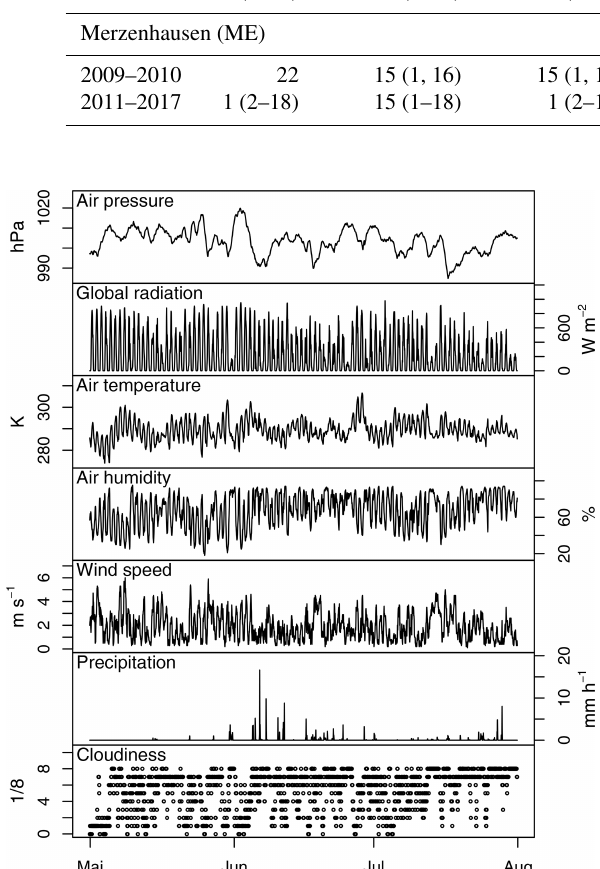
Figure 6. Excerpt of the gap-filled hourly meteorological data for the Selhausen site for the period from May until July